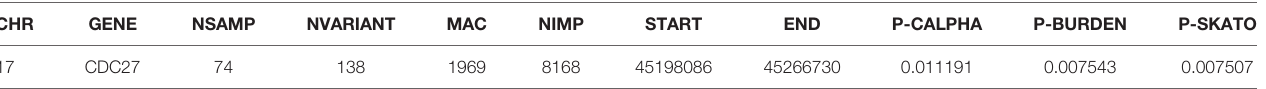
TABLE 1 | Results of family-based analysis using three types of burden (BURDEN, CALPHA, SKATO).